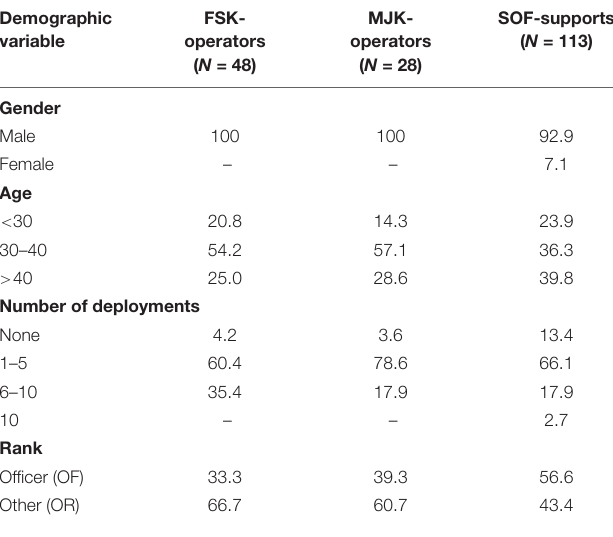
TABLE 1 | Demographic information of the sample (in